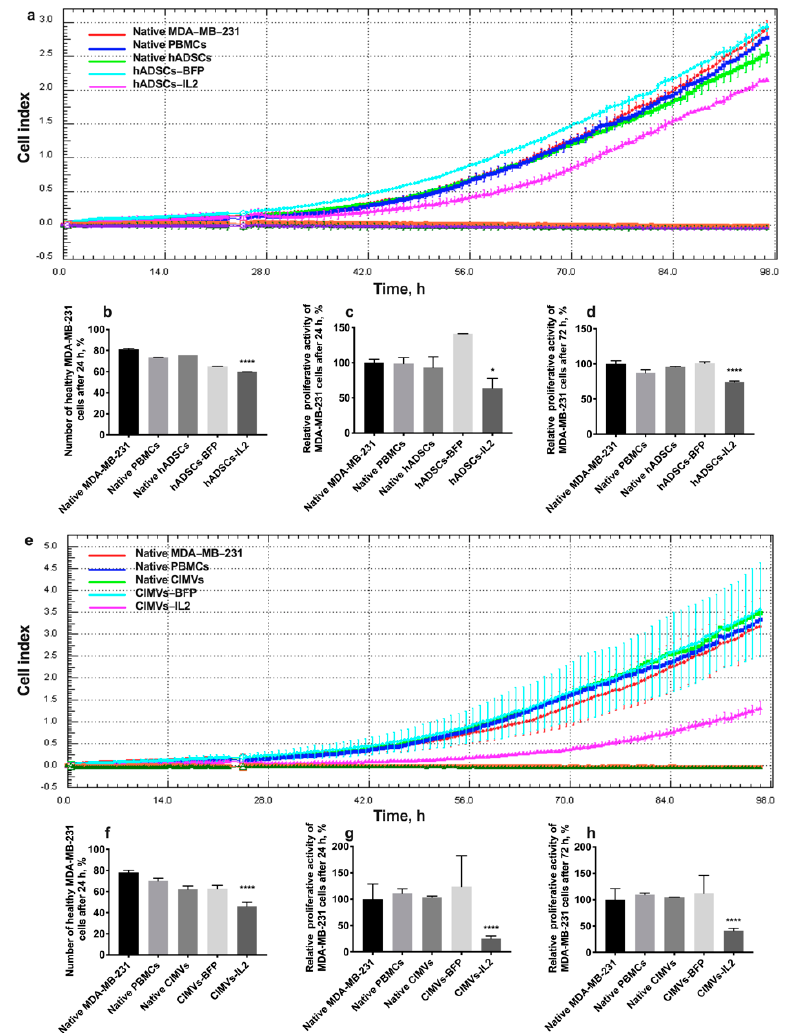
Figure 8. In order to assess the cytotoxic activity of hADSC- or CIMV-activated PBMCs against MDA-MB-231 triple negative breast cancer cells, proliferative activity and the number of apoptotic tumor cells were determined. After the addition of PBMCs activated with hADSCs-IL2, the proliferation of MDA-MB-231 cells was decreased by 36% at 24 h ( a , b ) and by 26% at 72 h ( a , d ). The number of nonapoptotic and non-necrotic MDA-MB-231 cells was also decreased after cultivation with hADSCs-IL2-activated PBMCs ( c ). After the addition of PBMCs activated with CIMVs-IL2, the proliferation of MDA-MB-231 cells was significantly decreased. Twenty-four hours after the addition of CIMV-IL2-activated PBMCs the proliferation of MDA-MB-231 was decreased 4-fold ( e , f ). The number of healthy MDA-MB-231 cells after 24 h of cultivation with PBMCs activated by CIMVs-IL2 was reduced by 35% ( g ). The proliferative activity of MDA-MB-231 cells after cultivation with CIMVs-IL2-activated PBMCs remained reduced by 59% after 72 h of cultivation ( e , h ). Each proliferation graph represents the changes in cells index (a unitless parament which indicates the impedance measured through gold electrodes on which the cells are seeded) over time. Each box represents the mean ± SD ( n = 4) of four biological replicates. Proliferative activity is calculated as % relatively to native MDA-MB-231 cells. The cell viability graphs ( b , f ) represent the absolute value of non-apoptotic/non-necrotic (healthy) cells found in the cell population. * p < 0.05, **** p < 0.0001.